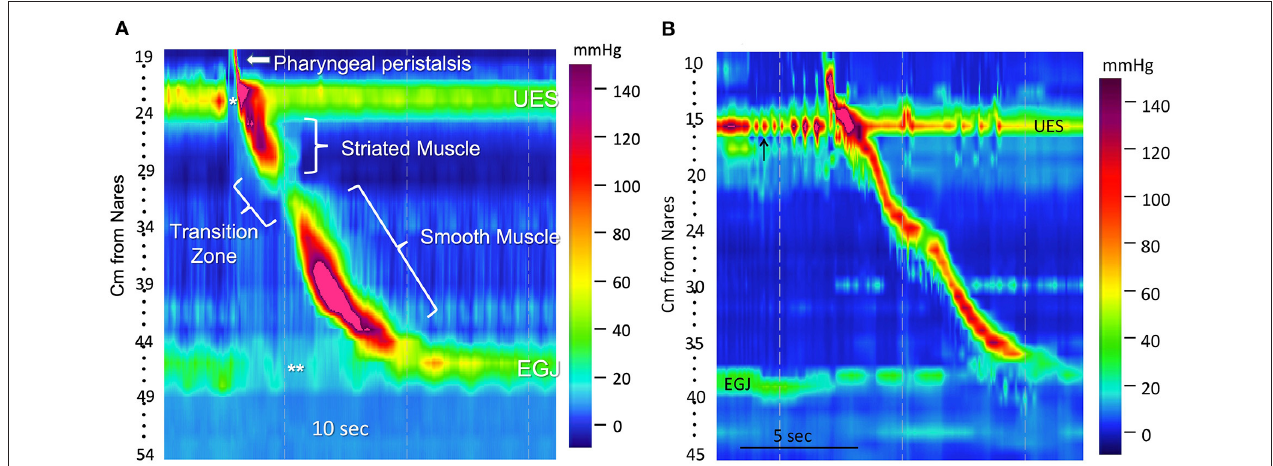
FIGURE 5 | A transition zone is present in humans, but lacking in dogs. (A) A high-resolution color topographical pressure plot of esophageal motor function produced by a 5-milliliter water swallow in a human. It was obtained with a high-resolution manometry (HRM) catheter placed to simultaneously record pressures from the pharynx to the stomach. Pressure is represented by color coding (interpreted on the basis of the color bar on the right), sensor location (distance from the nares in cm) is on the y-axis, and time is on the x-axis. Resting UES (upper esophageal sphincter) and EGJ (esophagogastric junction) pressures are seen as horizontal bands of color that are several centimeters in width. Their hues indicate pressures that are greater than those in the adjacent portion of the pharynx, esophagus, or stomach. Opening of the UES (*) and LES (**) are depicted as changes of color to hues that represent a lower pressure. The narrow, diagonal bar of color above the UES in the pharynx (arrow) represents a pharyngeal contraction. A diagonal band of color running from the UES to 30cm from the nares represents peristalsis of the striated muscle esophagus, and the diagonal band from 32cm to the EGJ represents peristalsis in the smooth muscle esophagus. The area of diminished pressure separating these two bands denotes the transition zone over which the muscle is transitioning from striated to smooth. (B) A high-resolution manometry esophageal topography plot showing a pharyngeal contraction and esophageal peristaltic pressure wave generated by the swallow of a 5g canned food bolus in a 7.2kg terrier mixed breed dog. There is a continuous diagonal color band from UES to LES representing an uninterrupted peristaltic wave. This continuous peristaltic wave occurs because, except for the LES, the dog esophagus is striated muscle and lacks a transition zone. There are rhythmic contractions of the UES just prior to the swallow (arrow). The genesis of this contractile pattern is unclear, but might represent mastication. (B) was reprinted from American Journal of Veterinary Research, Volume 77, Ullal TV, Kass PH, Conklin JL, Belafsky PC, Marks SL, High-resolution manometric evaluation of the effects of cisapride on the esophagus during administration of solid and